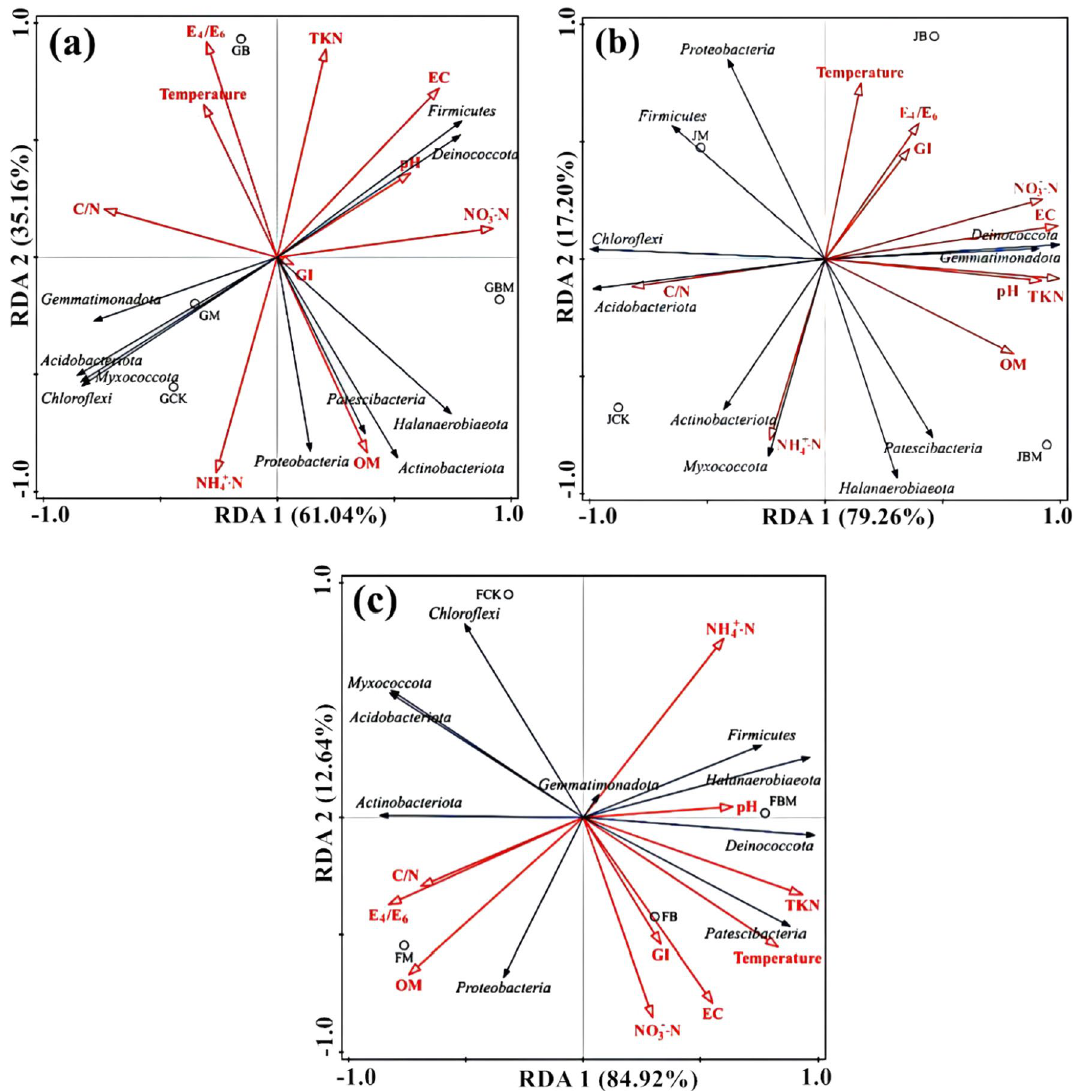
Fig. 8 Redundancy analysis (RDA) between environmental factors and microbial communities during thermophilic stage ( a ), cooling stage ( b ), maturity stage ( c